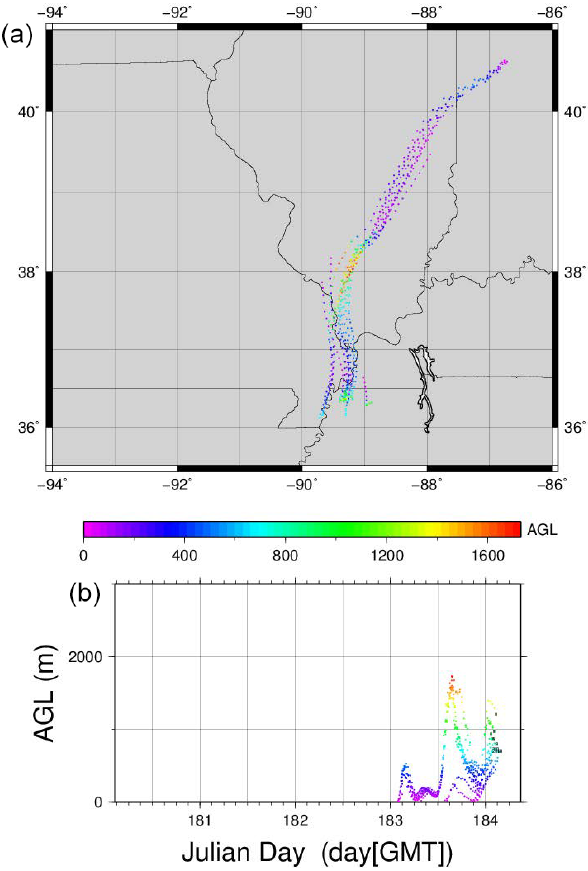
Figure 11. Detected fire hotspots on 3 July 2013 as daily composite: (a) hmxhysplit.txt and (b)